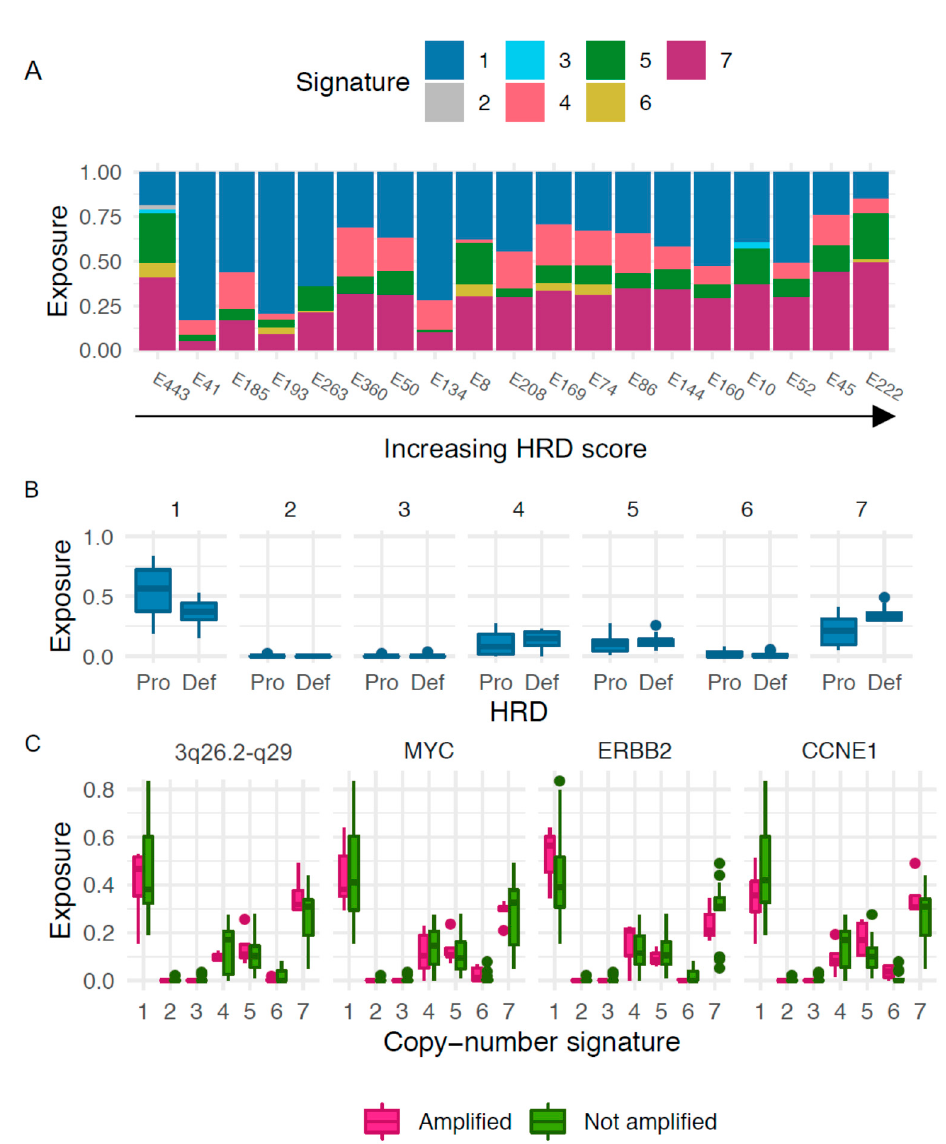
Figure 4. Copy-number signatures. ( A ) Distribution of exposure to the seven copy-number signatures with cases sorted by increasing HRD score. ( B ) Exposures to copy-number signatures for cases determined either HR proficient, “Pro” (score < 42), or HR deficient, “Def (score > 42). ( C ) Copy-number signatures in relation to amplified genes.